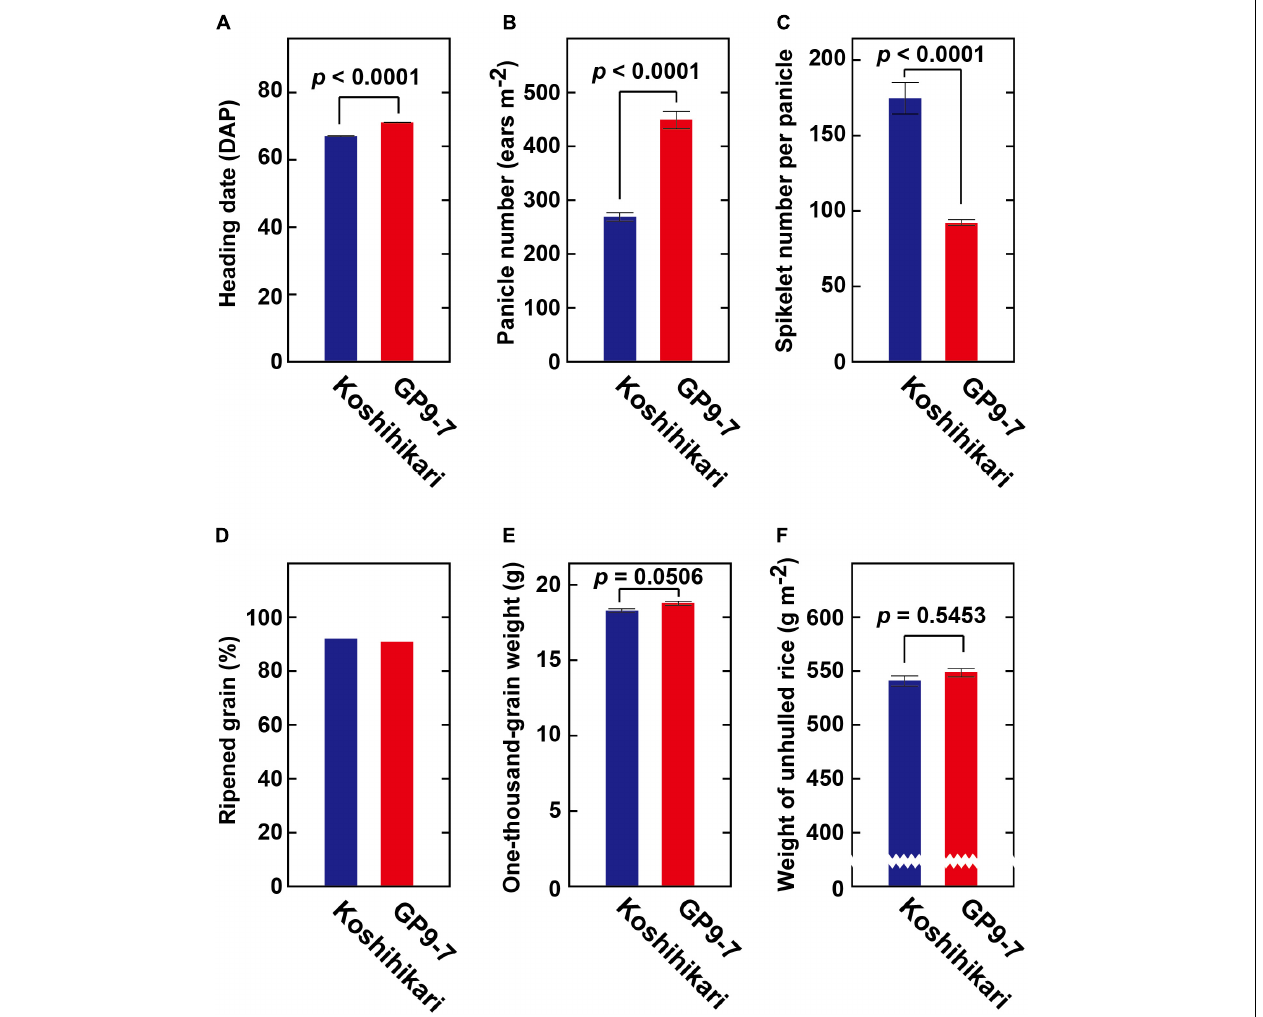
FIGURE 7 | Yield-related traits of GP9-7. (A) Heading date ( n = 12), (B) panicle number per m 2 ( n = 12), (C) spikelet number per panicle ( n = 12), (D) percent ripened grain ( n = 5), (E) one-thousand grain weight ( n = 3), and (F) weight of unhulled rice ( n = 3) of Koshihikari and GP9-7 cultivated in the test field at Tsukuba, Japan in the summer of 2018 (planting date: May 28, 2018) under sparse conditions (interplant space = 36 cm; 7.7 plants m − 2 ). P -values were calculated by the Welch’s t -test and are reported above the bar graphs. Mean values for Koshihikari and GP9-7 with SE values are indicated with blue and red bars, respectively.